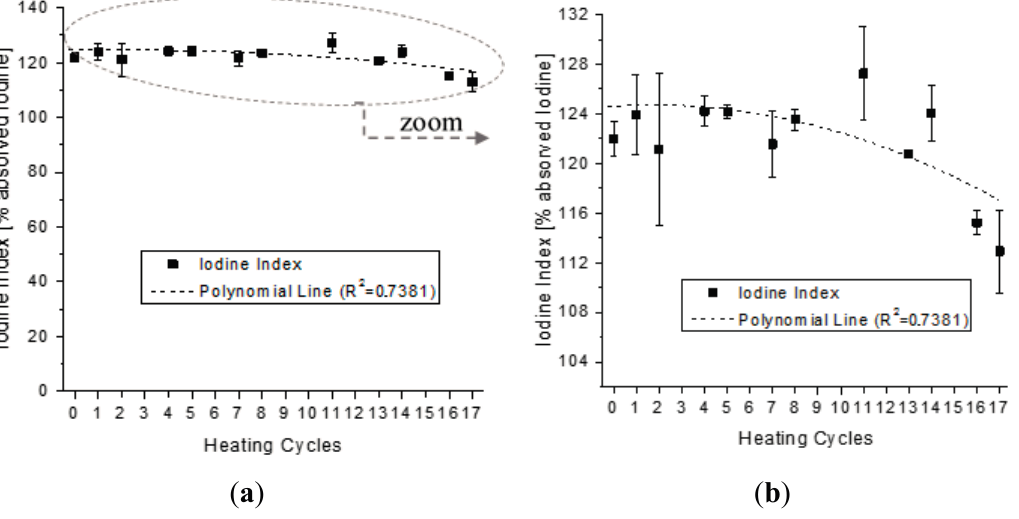
Figure 12. Value of the iodine index at 20 °C, for each one of the seventeen consecutive heating cycles, ( a ) in full scale; and ( b ) zoom on measurement